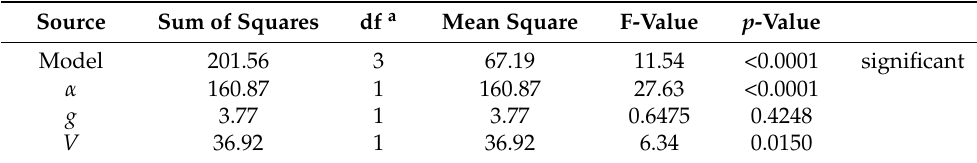
Table 6. ANOVA results. Dependent variable—specific cutting energy— E sce (J/mm 2 ).